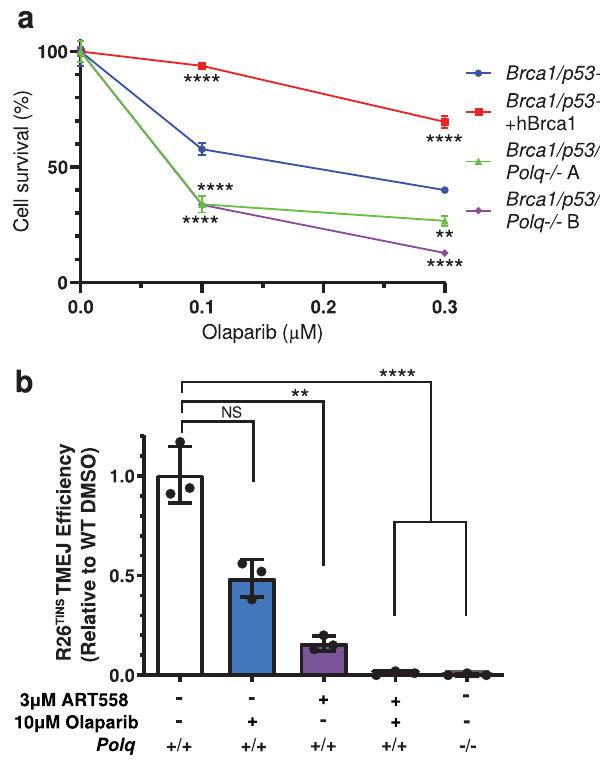
Fig.3|EffectsofcombinedimpairmentofTMEJandPARP.a Olaparibsensitivity of murine mammary tumor line KPB13 assessed by clonogenic survival assay. Par- ental line was Brca1/p53-/- (** p =0.0018, **** p <0.0001). b R26 MHD TMEJ ef fi ciency after 48h in MEFs treated with DMSO, olaparib, and/or ART558 normalized to WT DMSO(NS, p =0.23,notsigni fi cant;** p =0.0023,**** p <0.0001).Alldatashownare mean±SD( n =3).Statisticalsigni fi canceofdifferences,relativetotheparentalline ( a ) or WT DMSO ( b ) was determined by one-way